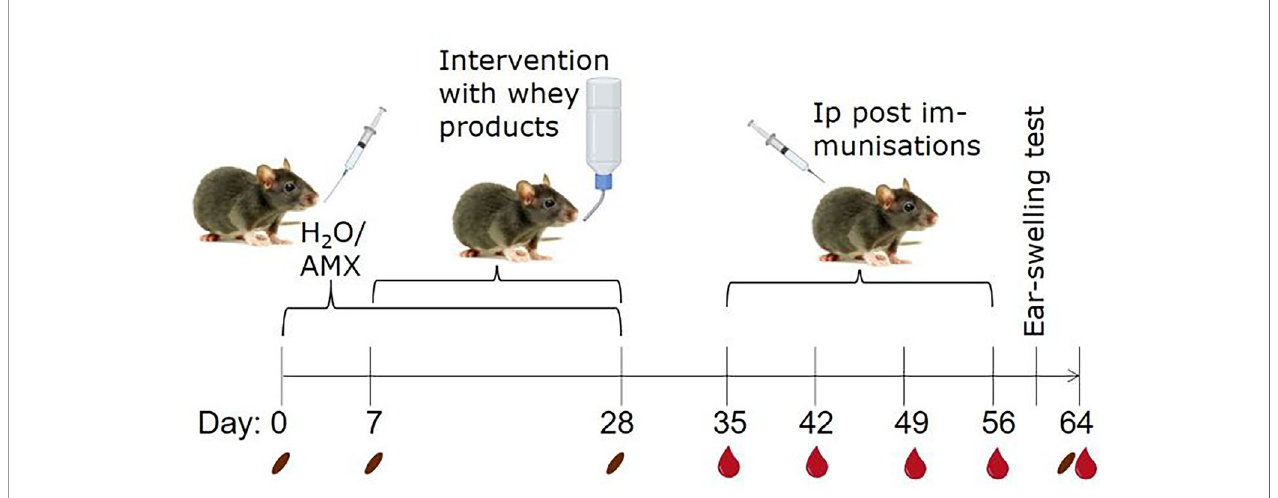
FIGURE 1 | Animal experimental design. To create two groups with different microbiota compositions, rats were gavaged daily with either amoxicillin (AMX) or water (H 2 O), as conventional control, from one week before and during whey product interventions. Brown Norway rats were administered one of four different whey products in their drinking water or water alone, ad libitum for three weeks. Subsequently, all rats were post-immunised by weekly intraperitoneal (ip) injections with intact whey (iW) for sensitisation for four weeks. The day before euthanisation, rats were subjected to an ear-swelling test by intradermal injection of iW. Blood and faecal samples were collected throughout the study on the indicated days. The pictures originate from BioRender.com and